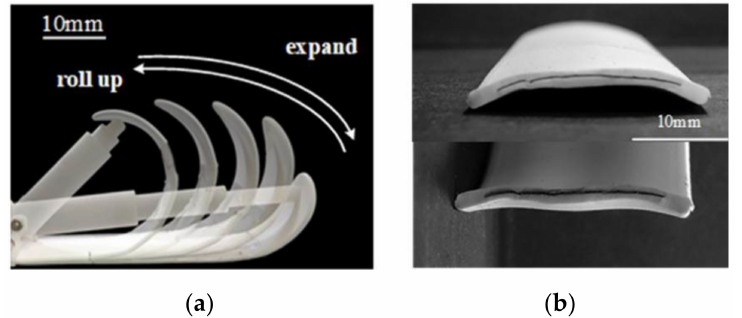
Figure 13. Several states of the toe movement process and substrate material. ( a ) Several states of the toe movement process; ( b ) cross-sectional view of substrate